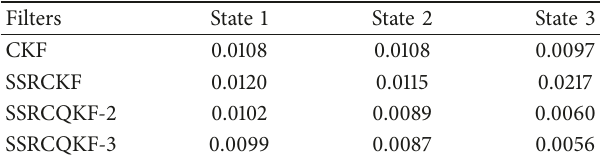
Table 2: Variance RMSE of state